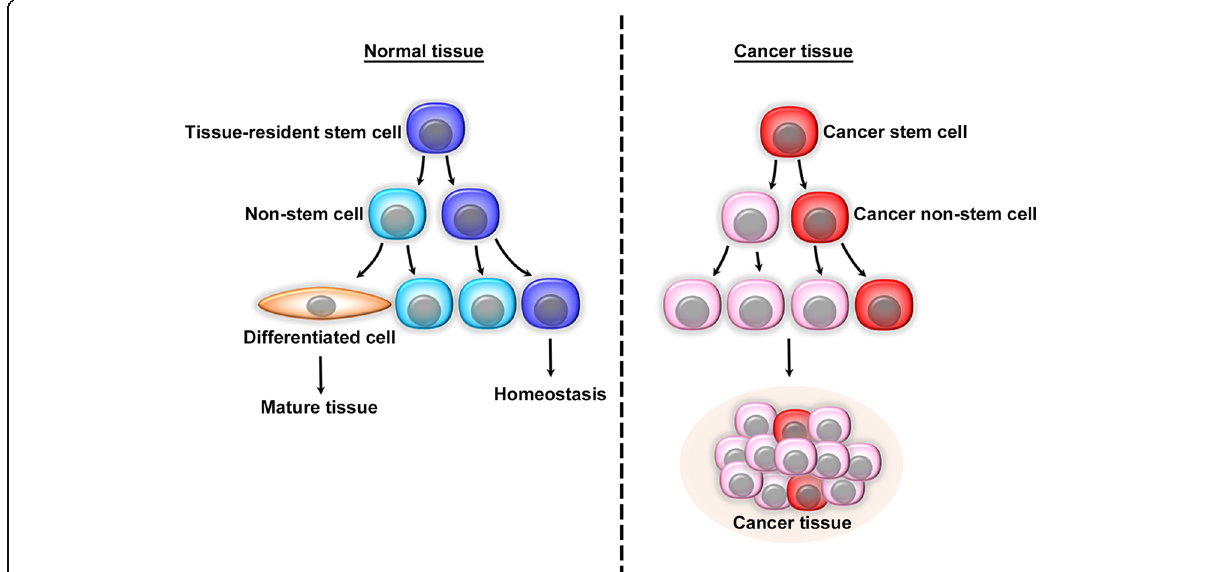
Fig. 1 Hierarchy of stem and non-stem cells in normal and cancer tissues. Normal tissue-resident stem cells generate new stem cells through symmetric divisions (producing two similar stem cells) or asymmetric divisions (producing one stem and one non-stem cells). Stem cells self- renew to maintain homeostasis while non-stem cells lose self-renewal capacity and differentiate into mature cell types to exert normal tissue functions. Like normal tissue-resident tissue stem cells, CSCs generate a small number of CSCs with self-renewal capability and cancer non-stem cells, which predominate cancer